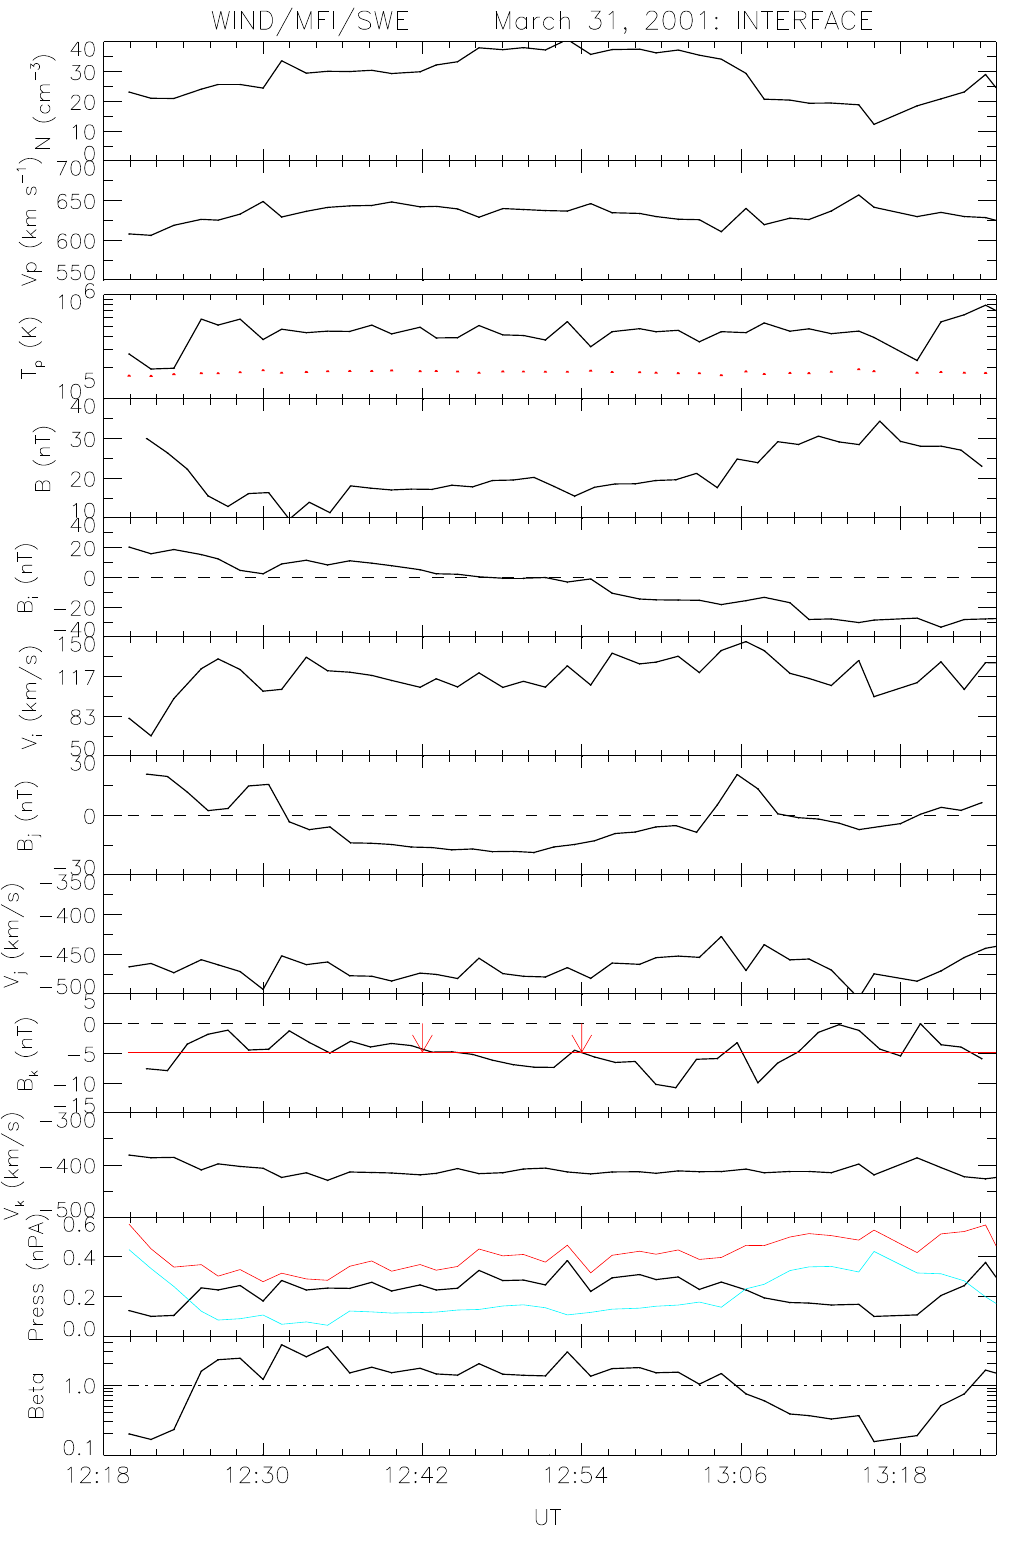
Fig. 9. The interface between ejecta 1 and 2. The panels show from top to bottom the proton density, bulk speed and temperature, (pairwise) components of field and flow in principal axes coordinates (i, j, k); the pressures (blue: magnetic field, black: plasma (electrons plus protons) and red: their sum), and the proton